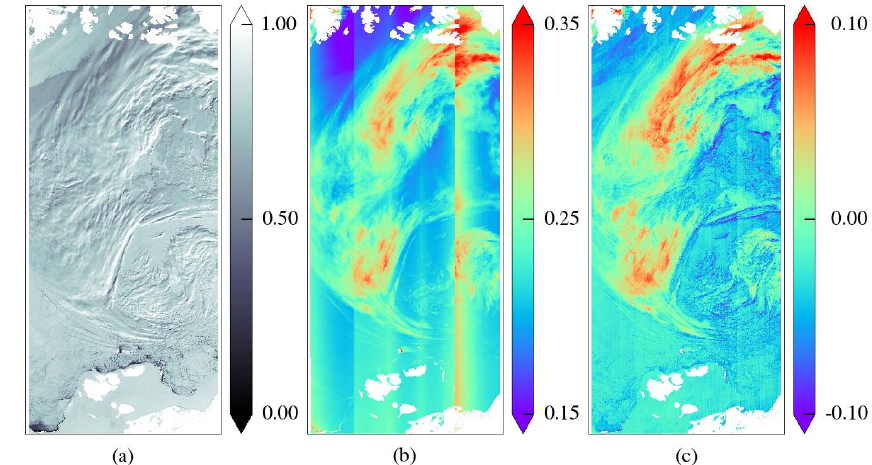
Figure 1. Reflectance at 779nm (a) , uncorrected oxygen A ratio (b) and corrected oxygen A ratio used as a feature in the cloud screening (c) . Shown is a 2450 × 1121 pixel part of Envisat orbit 37475 from 1 May 2009 with the New Siberian Islands at the bottom and parts of the Canadian Archipelago at the top. Land, open water and invalid pixels are white.